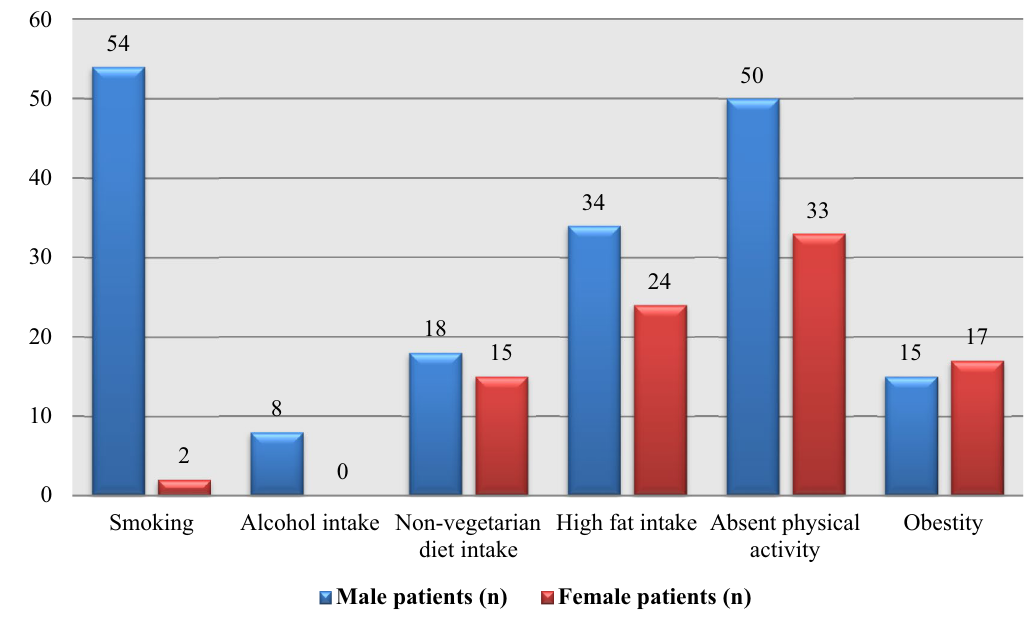
Figure 3. Depicts a comparison of lifestyle risk factors (n) in IHD patients.